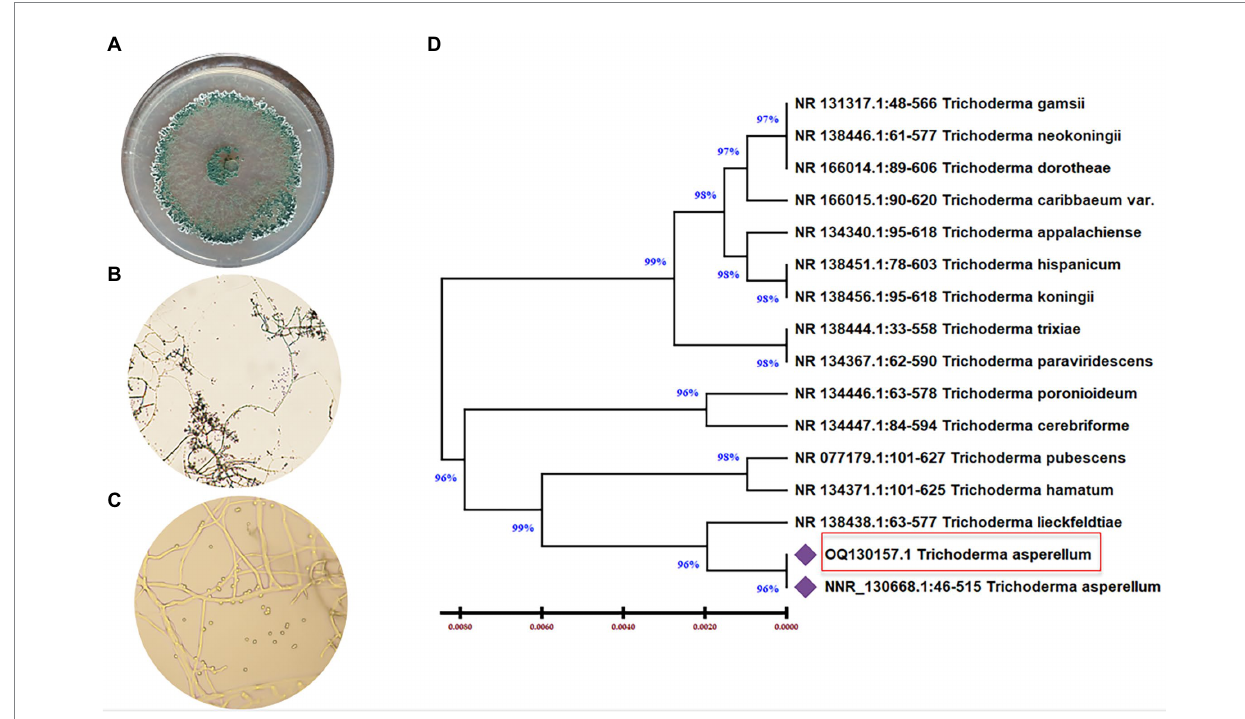
FIGURE 1 Morphological and molecular identification of T. asperellum . (A) The cultural view of T . asperellum grown on synthetic nutrient agar (SNA) media at 28 ° C for five days, which shows a ring around the original inoculum, (B,C) Microscopic view of conidia and conidiophores. (D) Molecular phylogenetic based on rDNA internal transcribed spacers (ITS) analyzes of T. asperellum by maximum Likelihood Model of MEGA11.0. The evolutionary distances were computed using the Maximum Composite Likelihood method and are in the units of the number of base substitutions per site. The proportion of sites where at least 1 unambiguous base is present in at least 1 sequence for each descendent clade is shown next to each internal node in the tree. This analysis involved 16 nucleotide sequences. All ambiguous positions were removed for each sequence pair (pairwise deletion option). The percentage of replicate trees in which the associated taxa clustered together in the bootstrap test (500 replicates) are shown next to the branches. The tree is drawn to scale, with branch lengths in the same units as those of the evolutionary distances used to infer the phylogenetic tree.